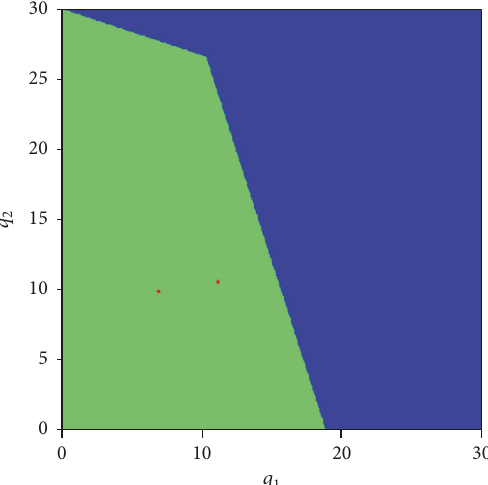
Figure 27: Basins of attraction, 𝛼 = 0.3 , 𝛽 = 0.25 , and 𝑞 3 = 7 .